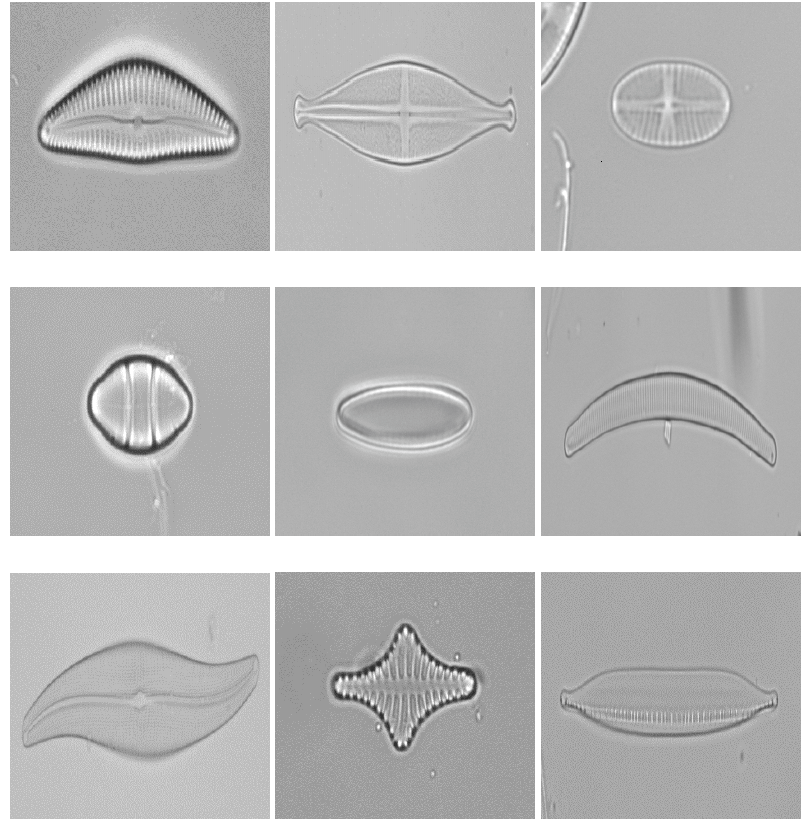
Figure 5. Nine of the 50 diatom images taken from the public data Automatic Diatom Identification and Classification (ADIAC) project employed to test the Parameter Segmentation Tuning (PST) technique.